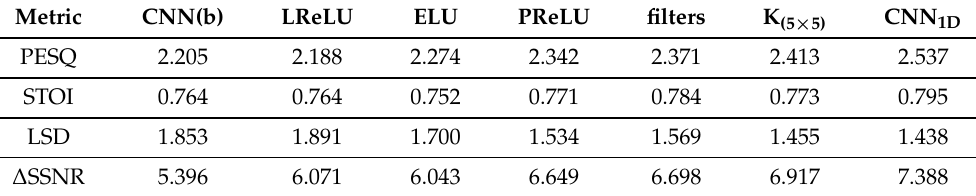
Table 6. Effect of CNN related hyperparameters: activation functions, e Rectified Linear Unit